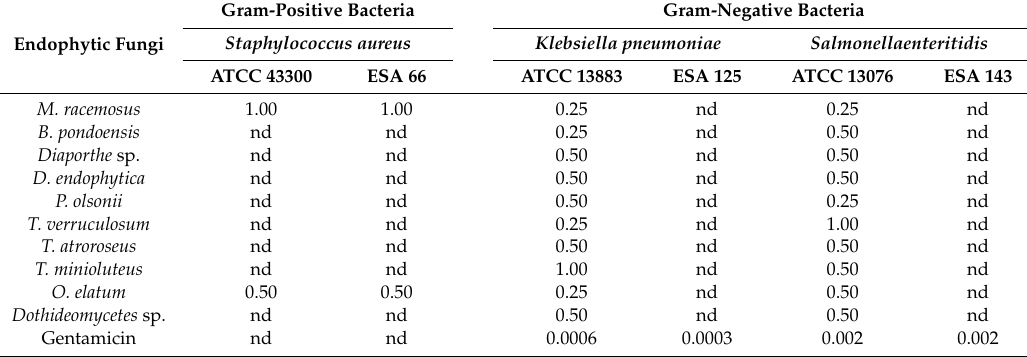
Table 7. Minimum bactericidal concentration (MBC) (mg / mL) of the extracts from endophytic fungi isolated from S. terebinthifolius .